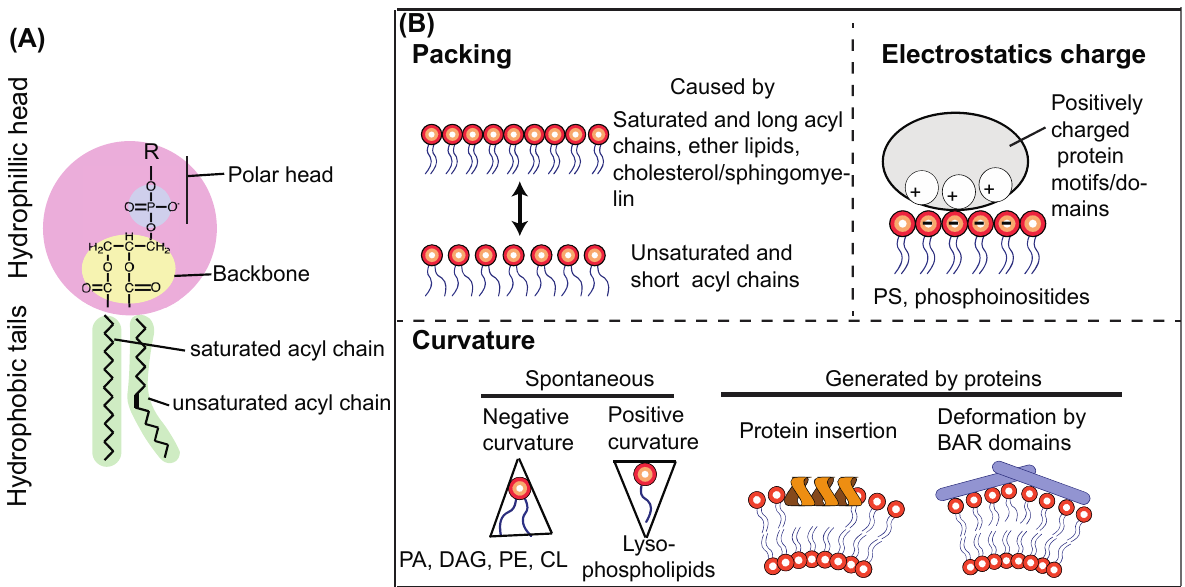
Figure 5. Physicochemical parameters that affect activities and membrane binding of autophagy-related proteins. ( A ) A schematic structure of a phospholipid molecule. A phospholipid is composed of a polar head comprising a modified alcohol (R) and a phosphate, a backbone (glycerol here, also can be sphingosine), and fatty acids or acyl chains. R in the polar head defines the lipid species, such as serine for PS, ethanolamine for PE, choline for PC, and inositol for PtdIns. The polar head and backbone constitute hydrophilic head, facing the aqueous side of the membrane, whereas the acyl chains provide a hydrophobic barrier. ( B ) Three important physicochemical parameters that affect activities and membrane associations of autophagy-related proteins: packing, membrane curvature, and electrostatics.